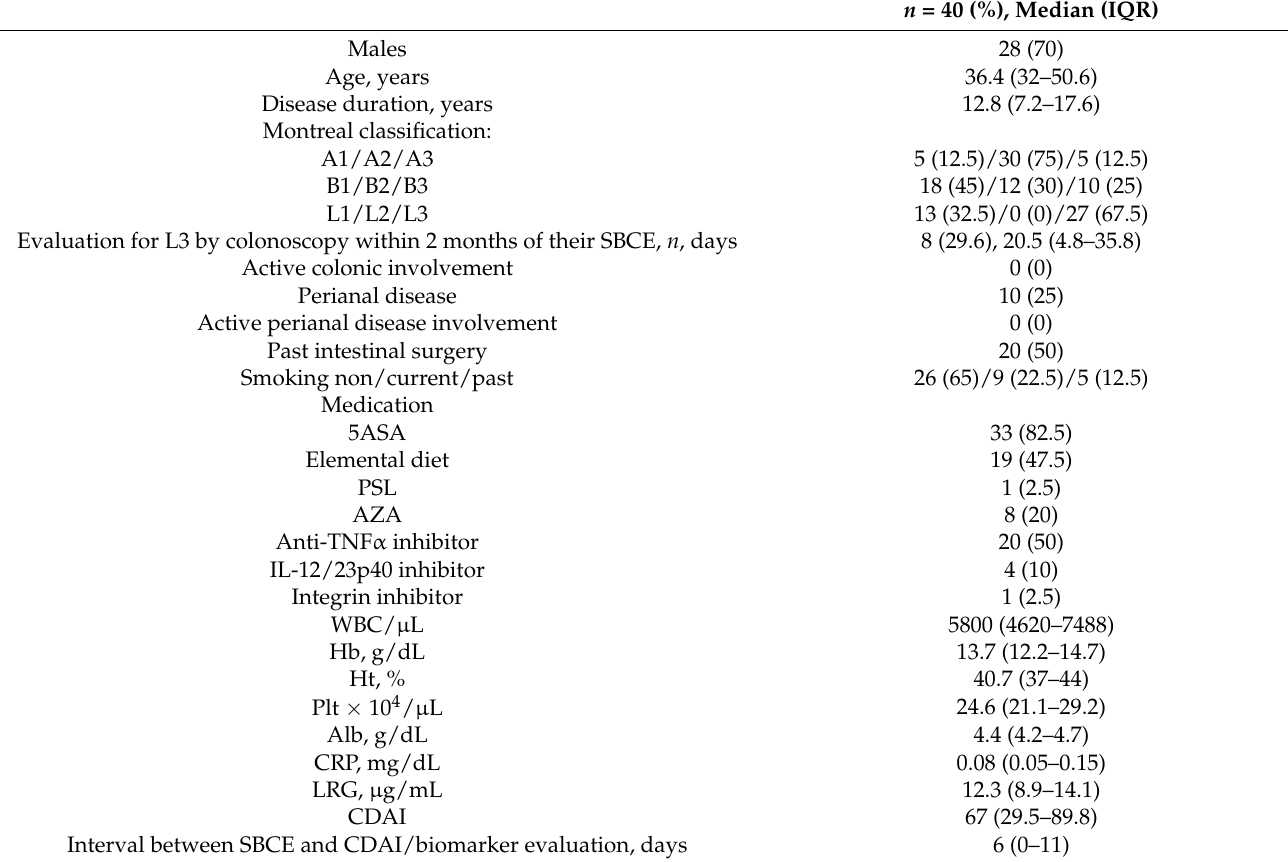
Table 1. Demographic and clinical characteristics of the patients with